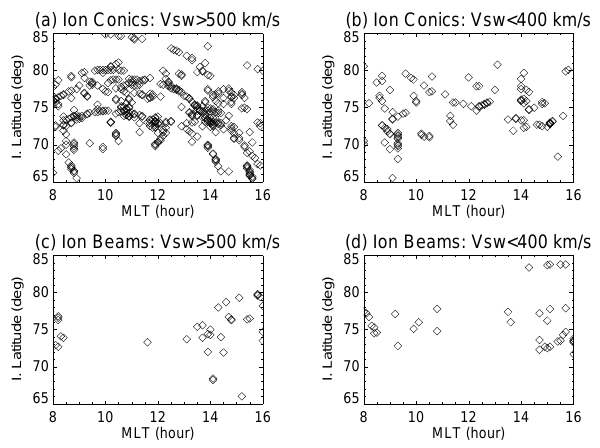
Fig. 6. Locations of energetic ( > 100eV) ion conics (upper panels) and beams (lower panels) in MLT-I.Lat coordinate when the solar wind velocity is large (left) and small